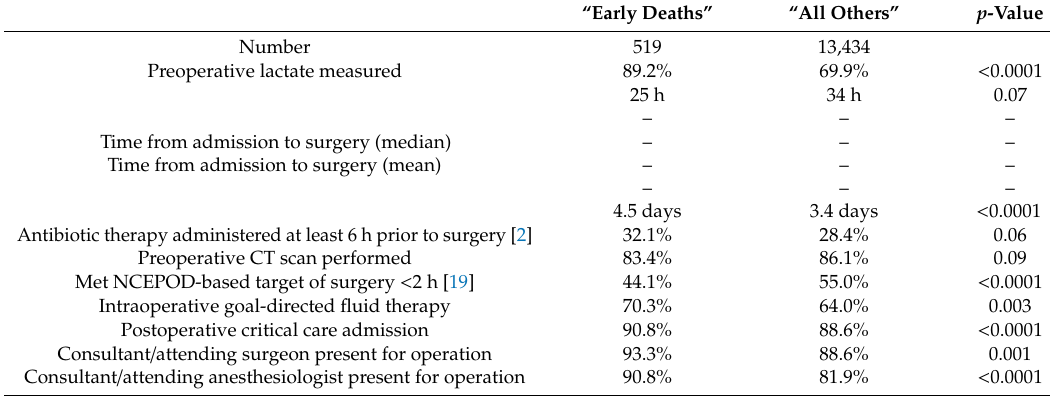
Table 2. Compliance of patients with the standards of care outlined by the Emergency Laparotomy Collaborative care bundle for patients undergoing emergency laparotomy. “Early